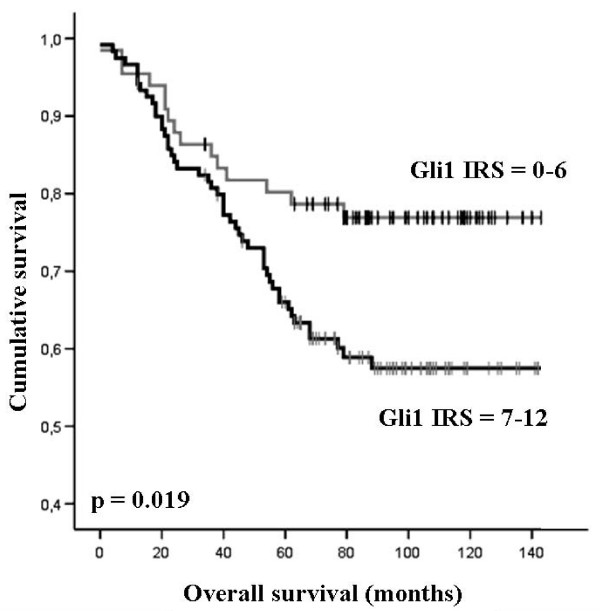
Breast cancer patients expressing nuclear GLI1 protein show unfavourable prognosis. Univariate Kaplan-Meier analysis was performed on the basis of GLI1 expression results derived from the TMA. Patients with low GLI1 expression (IRS = 0–6) displayed improved overall survival estimation (upper graph) compared to patients with abundant nuclear GLI1 expression (IRS 6–12; lower graph) (P = 0.019; univariate log-rank analysis).